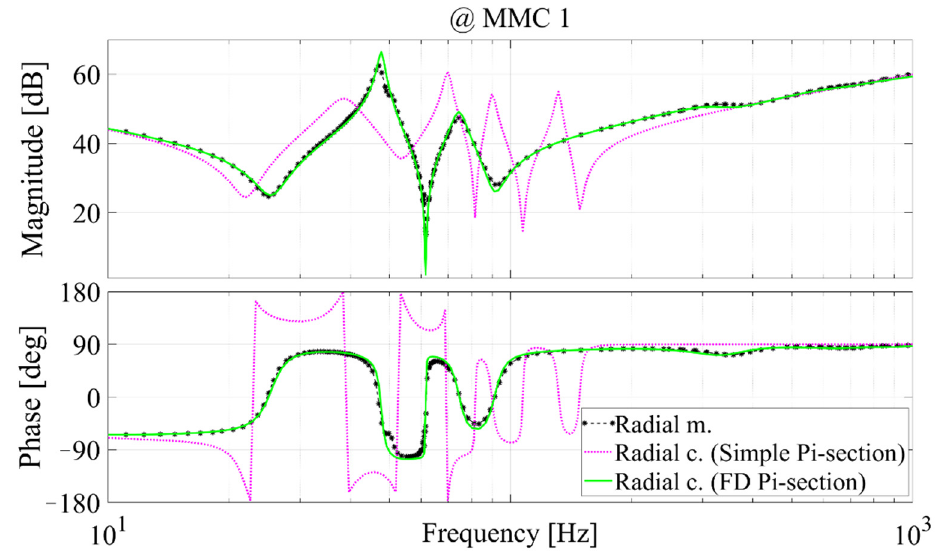
Figure 9. DC network impedance seen at MMC 1 with simple and FD-Pi sections.